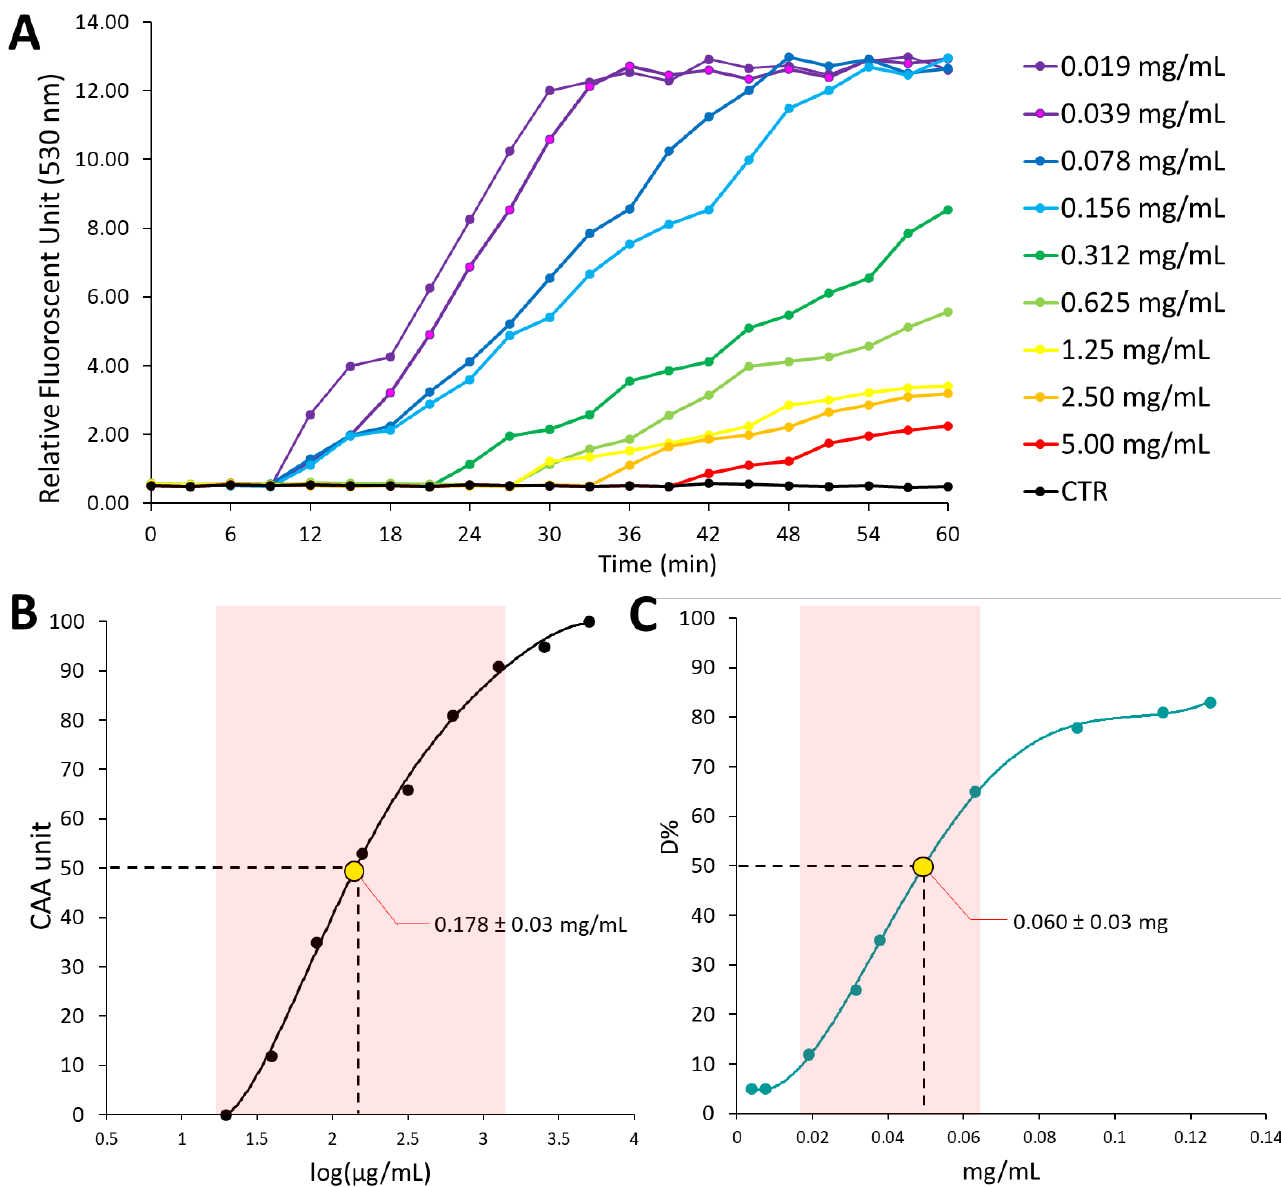
Figure 1. Antioxidant properties of the WRSP extract. Panel ( A ) shows the relative fluorescence of treated (mg/mL per cell medium) or untreated (control) HepG2 cells evaluated each 5 min for 1 h, after exposure to 600 µM ABA, as reported in materials and methods. Panel ( B ) shows the dose- response (CAA) curve, used to calculate CAA 50 value, reported with the yellow dot. Panel C shows dose-response (D%) curve obtained from the decolorization of radical ABTS solution, after adding different concentrations of the WRSP extract, as reported in materials and methods. The yellow dot in Panel ( C ) shows the WRSP concentration (mg/per mL of reaction mix) necessary to 50% decolor- ization of the radical ABTS solution (D 50 ). The red box represents the linear portion of the curve within which the CAA 50 and D 50 values were determined.